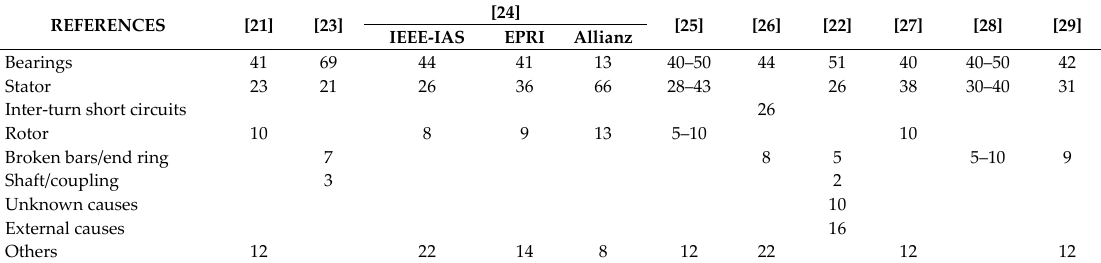
Table 4. Failures according to the engine part (%).